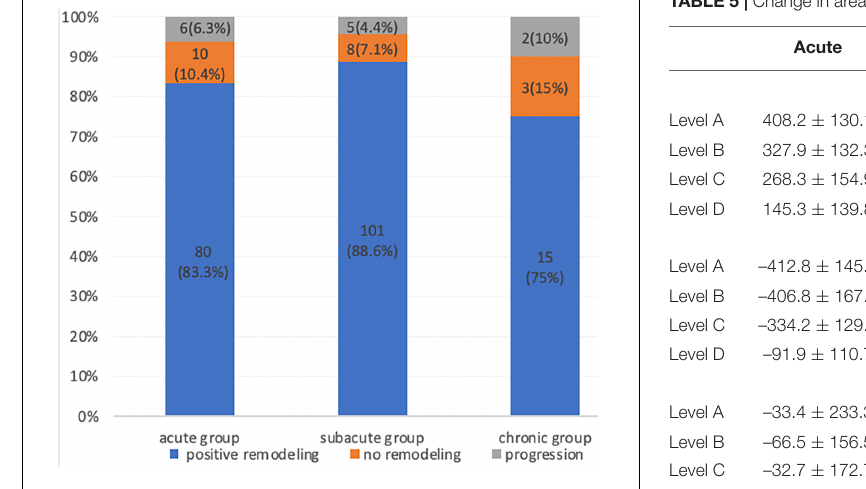
FIGURE 2 | Proportion of patients with aortic remodeling (positive remodeling, no remodeling, and progression) during the CTA follow-up after thoracic endovascular aortic